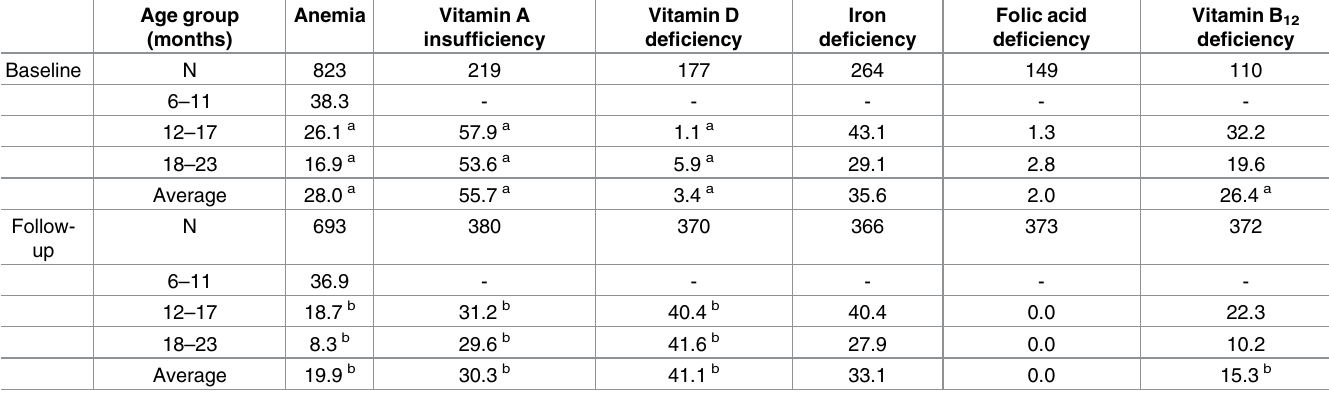
a Values in the same age group without the same superscript letter are different at the P < 0.05 level. b Values in the same age group without the same superscript letter are different at the P < 0.05 level. - No data reported due to a lack of venous blood samples.